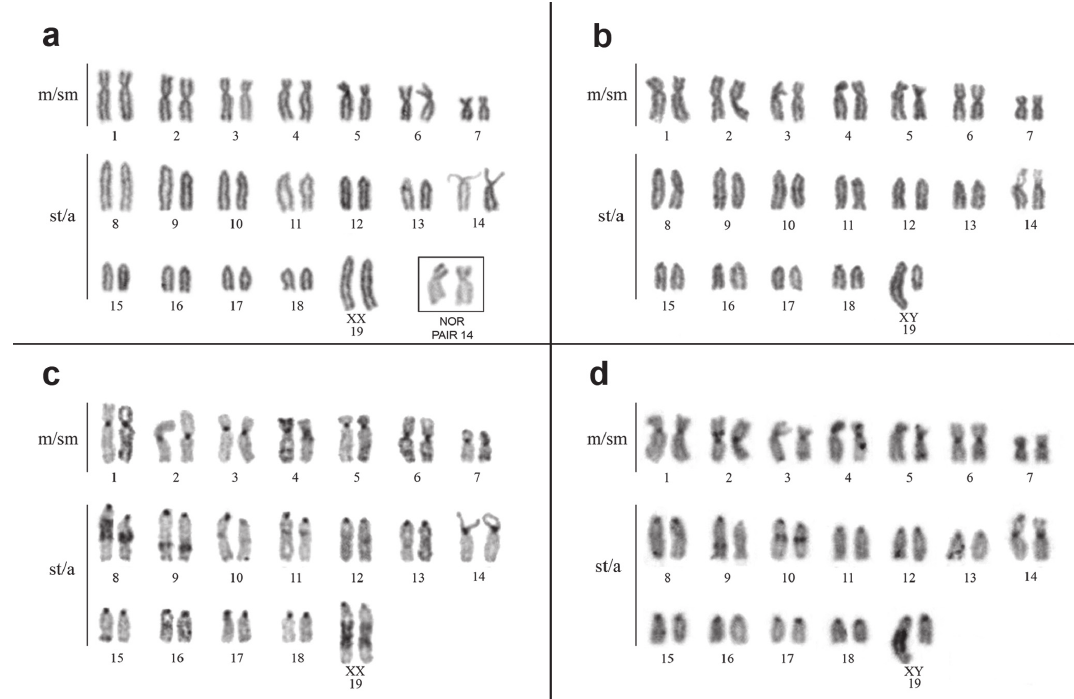
Fig. 6. Karyotype of Eigenmania sp. “B” with 2n = 38, XX/XY from the rio Quatipuru. Male karyotype stained with Giemsa (a) and C banding (c). Box inset: pair 14, with NOR. Female karyotype stained with Giemsa (b) and C banding (d). Legend: m/sm = metacentric/submetacentric and st/a =